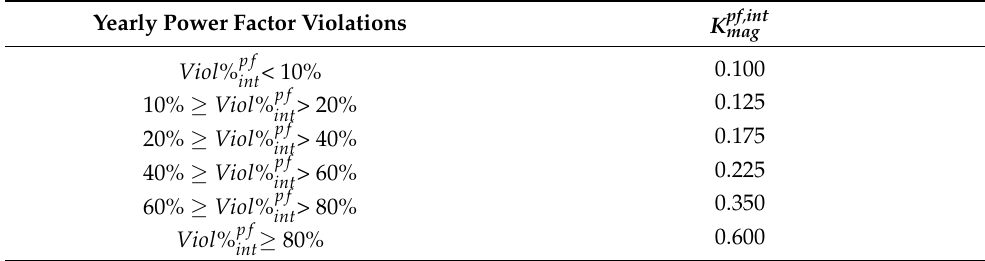
Table 4. Case study: magnitude factor for the power factor infringement penalty.